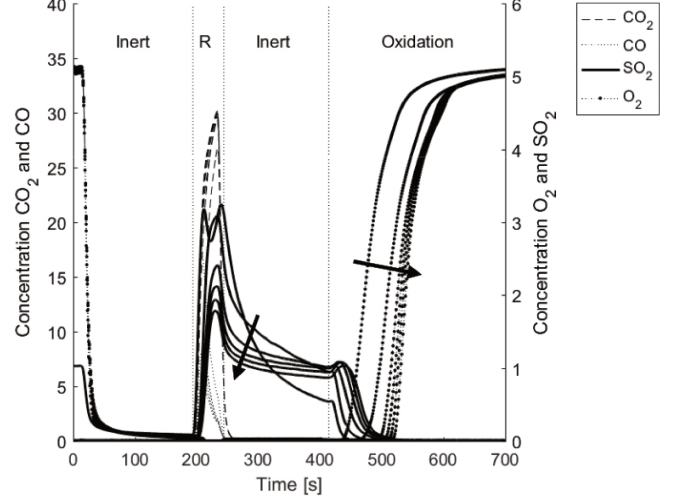
Figure 15. The concentration of outgoing gases for reduction cycles after LD slag has been loaded with SO 2 during oxidation. Arrows show development after every cycle; decreased SO 2 out from every cycle and increased time for oxygen breakthrough. Dotted vertical lines indicate the atmospheric conditions in every cycle; “R” is reduction using syngas.